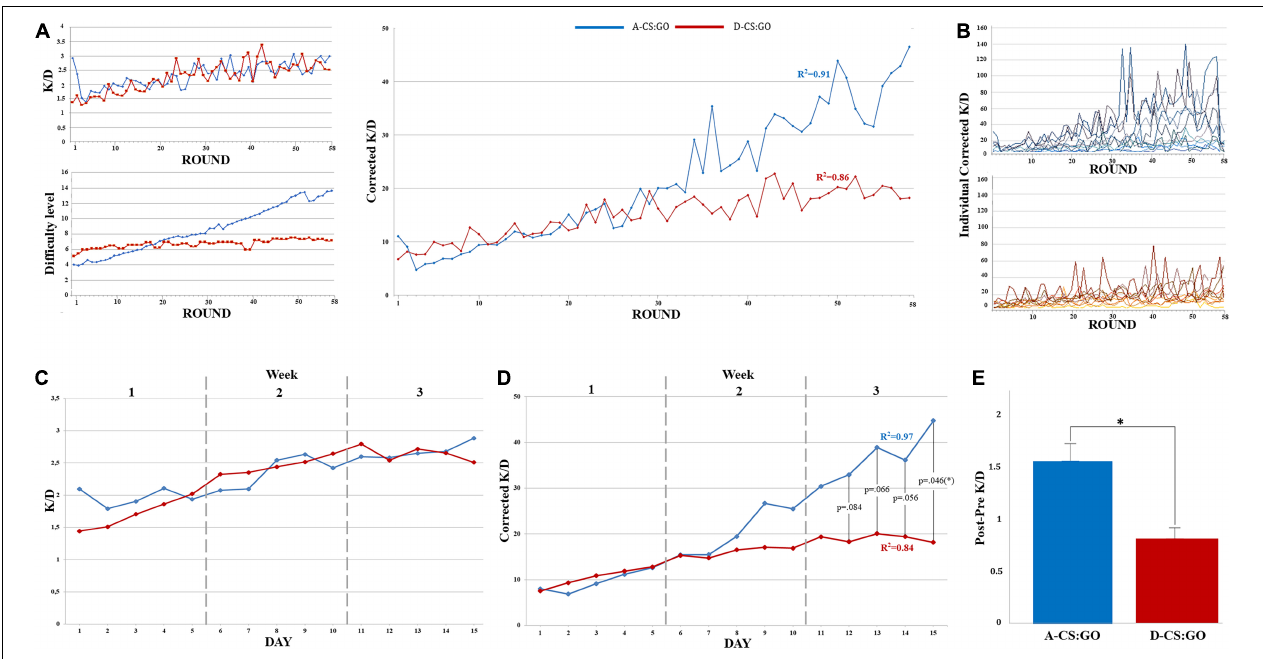
FIGURE 3 | Graphical depiction of the in-game progression for both A-CS:GO and D-CS:GO groups. (A) uncorrected K/D ratio, difficulty levels and corrected K/D ratio of the training rounds. (B) Individual corrected K/D ratio changes during training rounds. (C) K/D ratio during the training days. (D) Corrected K/D ratio during the training days. After an initial equivalent performance between A-CS:GO and D-CS:GO groups, the corrected K/D ratio progressively increased in the A-CS:GO group and the performance of the A-CS:GO group becomes significantly higher than the CS:GO group performance. (* p < 0.05 – higher performance in the A-CS:GO group). E: Pre-training corrected K/D was subtracted from post-training performance for both groups, highlighting a significant improvement of performance after the A-CS:GO training (* p <